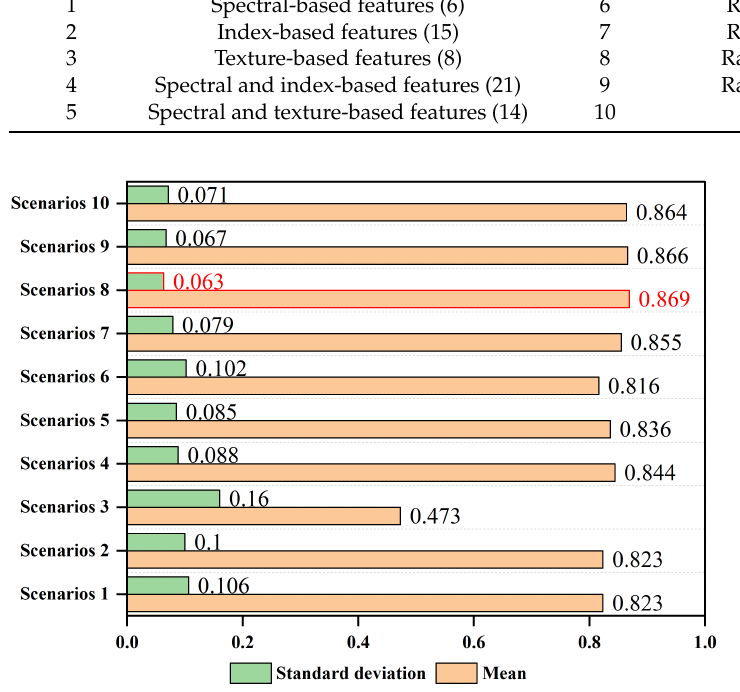
Figure 11. Comparison of accuracy of different feature